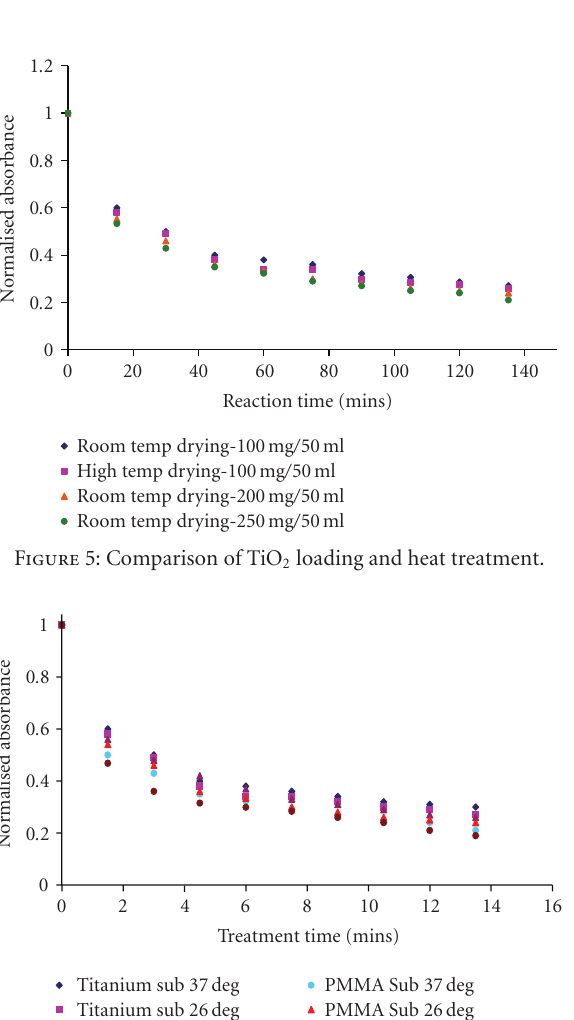
Figure 6: Comparison of substrate material with reactor plate angle at the optimum TiO 2